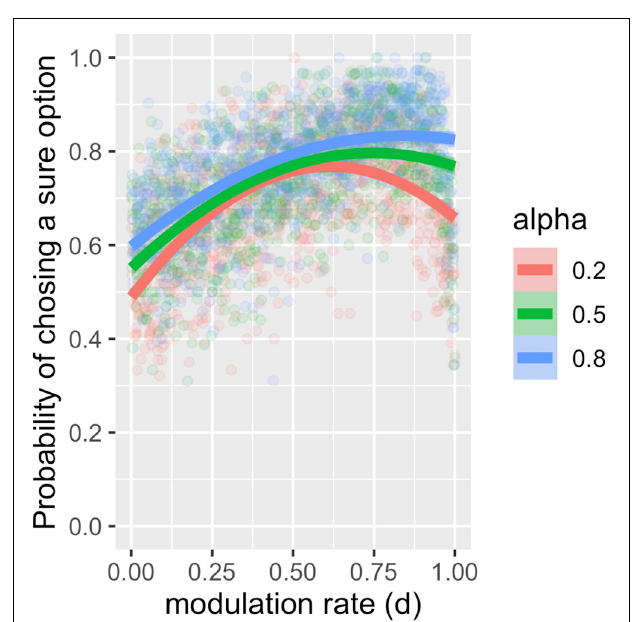
FIGURE 2 | Plot and second-order polynomial fit for the probability of choosing a sure option depending on the surprise decay rate and learning rate. We found that risk aversion increased as the surprise decay rate ( d ) increased in the surprise-sensitive utility model and that this tendency increased as the learning rate ( α )